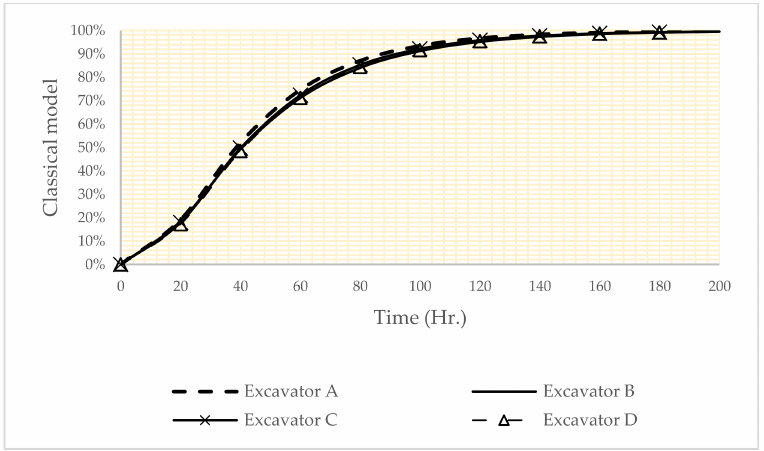
Figure 6. The results reliability importance measure in the classical model reliability.